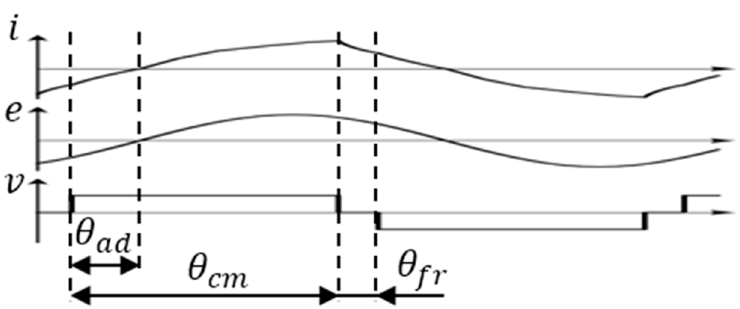
Figure 8. Advance angle and conduction angle controls.